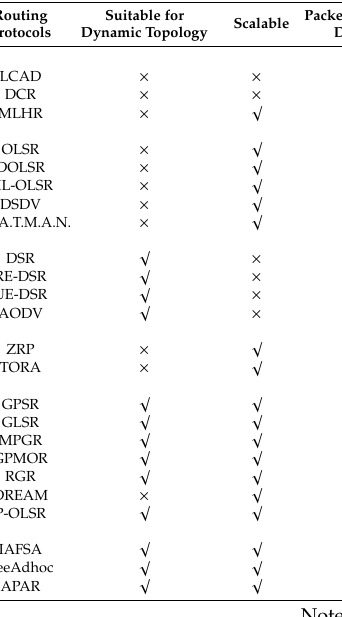
Table 3. Summary of Routing